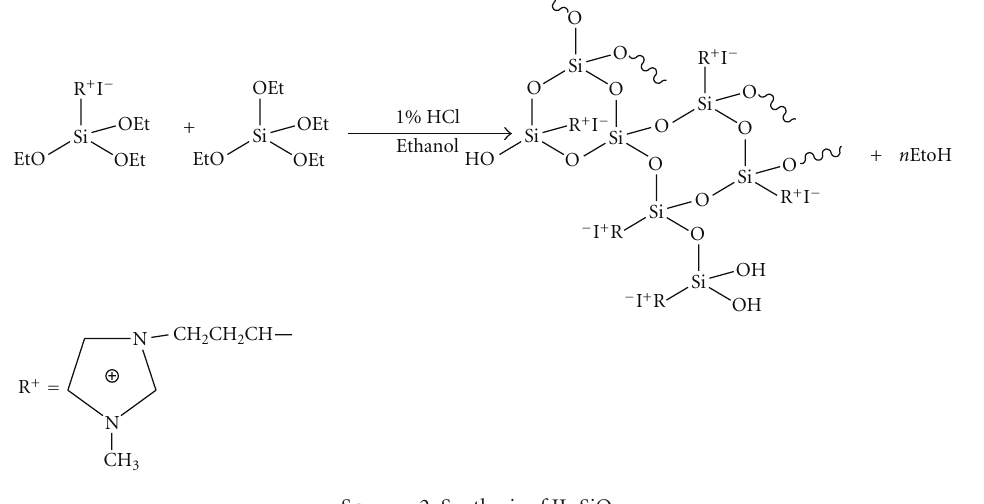
Scheme 2: Synthesis of IL-SiO 2 .